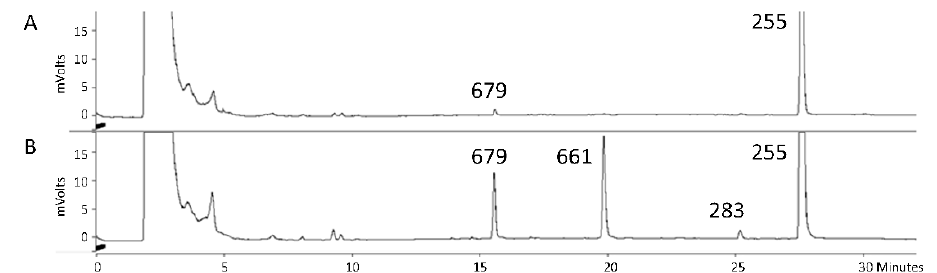
Figure 4. Comparison of the production of C16:0 sophorolipids on palmitic acid ( A ) versus ethyl palmitate ( B ). The acidic di-acetylated C16:0 sophorolipids eluted at 15.5 min (679 m / z ), and the lactonic di-acetylated C16:0 sophorolipids at 15.8 min (661 m / z ). The substrate ethyl palmitate eluted at 25.1 min (283 m / z ) while palmitic acid eluted at 27.5 min (255 m / z ). It has to be noted that these